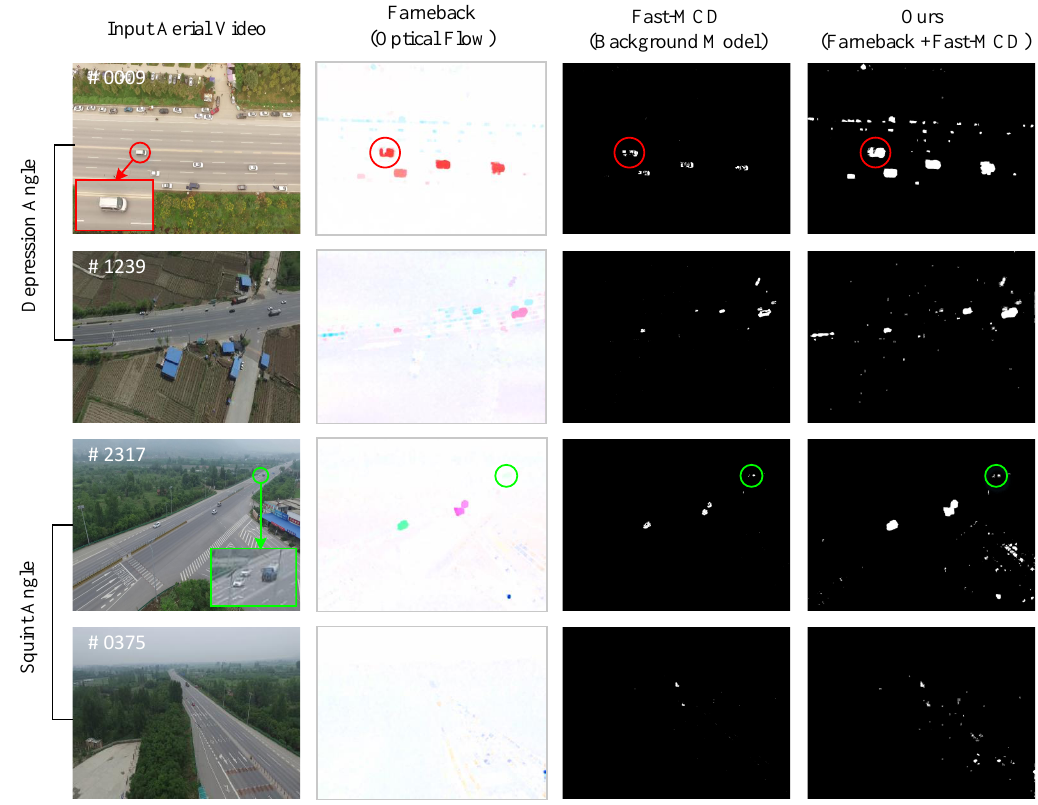
Figure 8. Contrast foreground segmentation result of the background modeling method Fast-MCD (the second column), the optical flow method Farneback (the third column), and the proposed multi-cue foreground segmentation method (the fourth